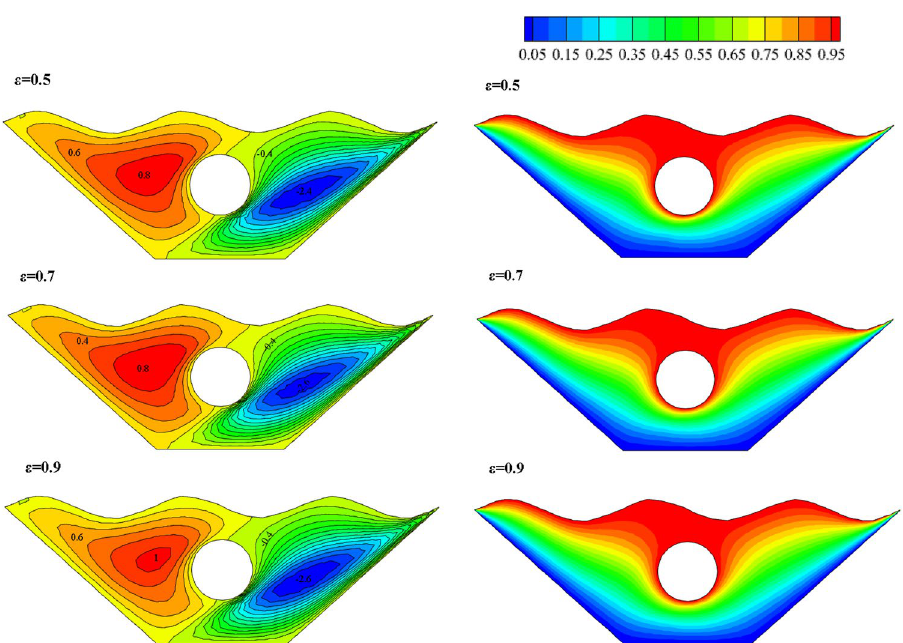
Figure 8. Stream functions and Isotherms for different values of porosity ( ℇ ) at Ra = 500, Ha = 20, Rd = 0.5 and α =